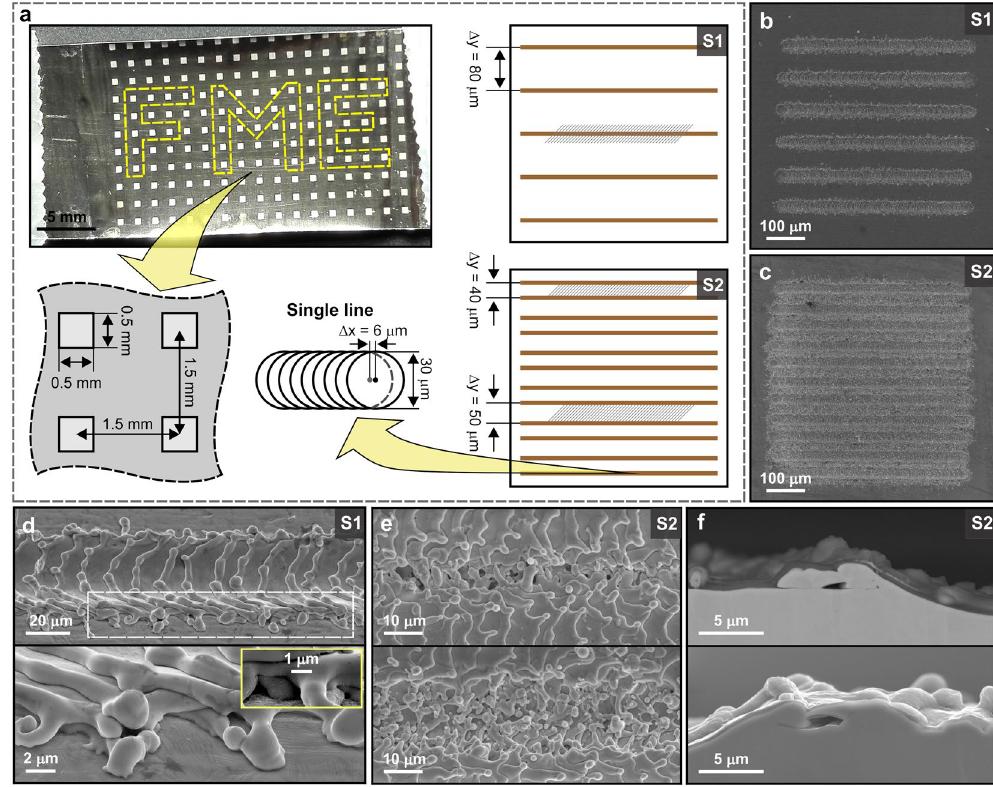
Figure 1. Laser-textured surfaces. ( a ) Stainless steel foil with laser textured array and schematic presentation of laser-texturing method. ( b ) SEM images of square, textured by S1 and ( c ) S2 structure. Magnified SEM images of ( d ) S1 structure [marked area in S1 in ( a )] and ( e ) S2 structure in the border between two channels [marked areas in S2 in ( a ) – top for Δ y = 40 μ m, bottom for Δ y = 50 μ m]. ( f ) Cross section of